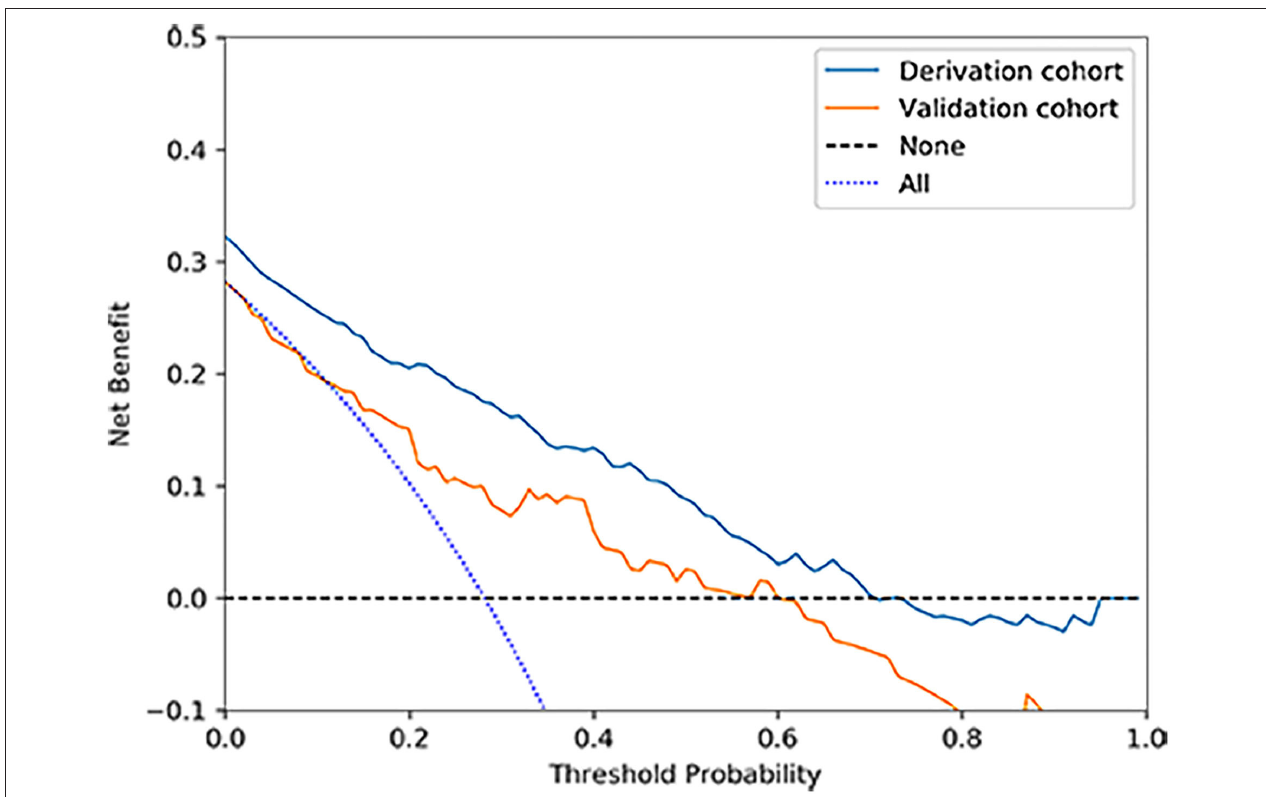
FIGURE 4 | Decision curve analysis for the nomogram in derivation and validation cohorts. The nomogram to predict IA rupture would generate more NB than the “treat all” or “treat none” strategies and generate the maximum NB of about 0.18 and 0.26 for the derivation and validation cohort at the decision threshold of